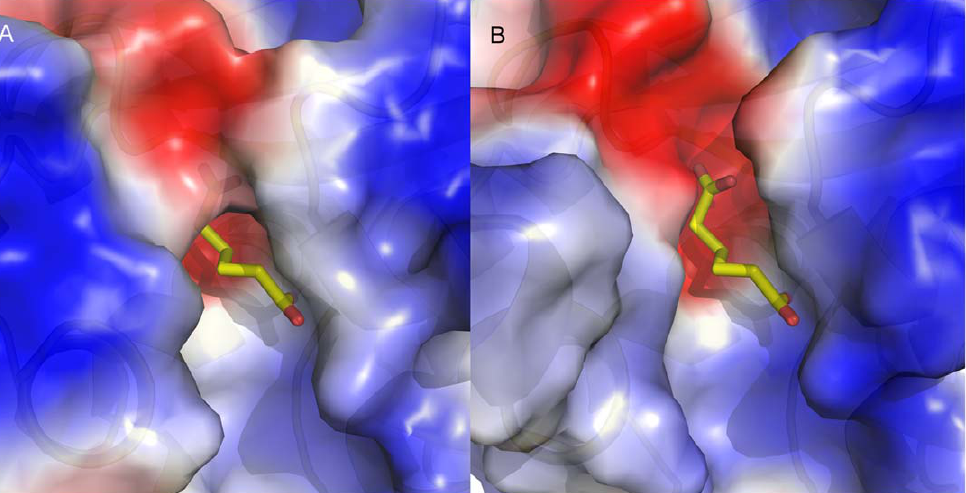
Figure 5. Peptidyl-tRNA hydrolase from B.thailandensis . (A) The electrostatic surface of unliganded peptidyl-tRNA hydrolase (PTH, Bth_I0472, PDB: 3V2I) from B. thailandensis is superimposed with a cartoon representation of a structure from P. aeruginosa with bound adipic acid (PDB: 4DHW). The channel in unliganded 3V2I is closed due to adjacent flexible loops. (B) The electrostatics surface of 4DHW reveals an open, charged channel. 3V2I and 4DHW have 44% sequence identity and a similar overall fold (2.0 A˚ RMSD over all common C a atoms). Discovery of a ligand that binds the alternately charged channel (positive/negative/positive) could block the reaction and prevent protein synthesis.